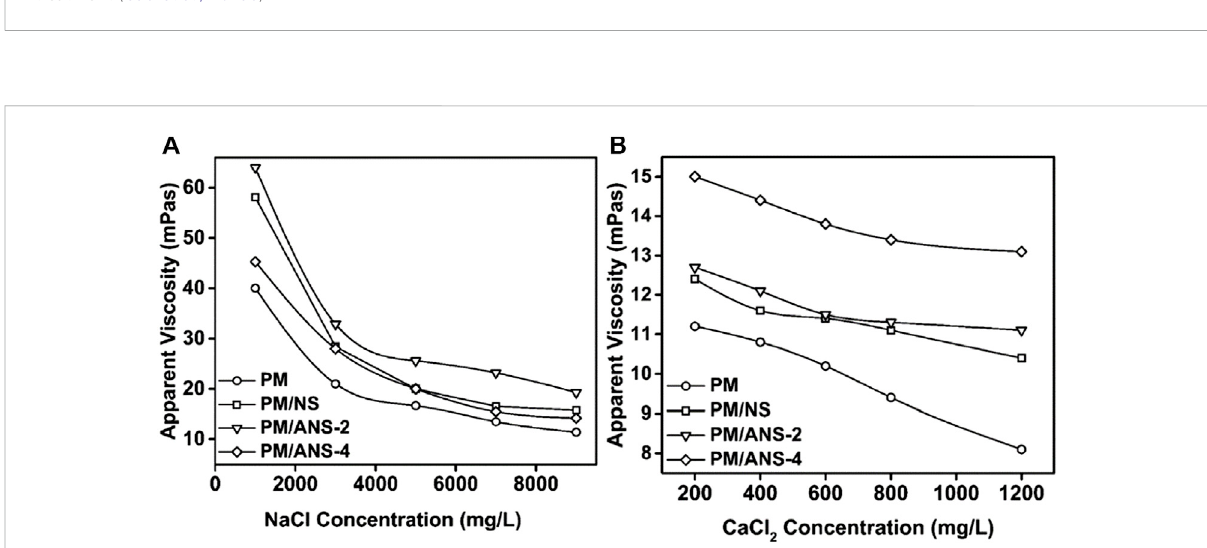
FIGURE 6 (A) DependenceofpolymerviscosityonsalinitywithadditionofdifferentAPTES-treatednanoparticles; (B) dependenceofviscosityonhardness (Cao et al.,